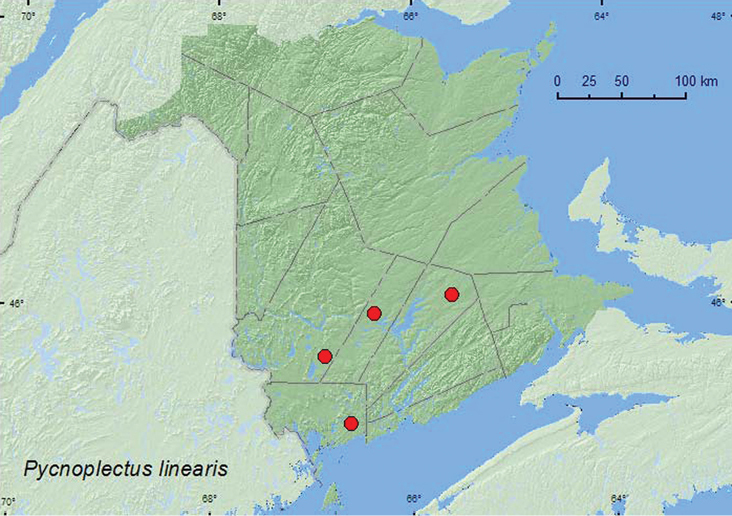
Collection localities in New Brunswick, Canada of Pycnoplectus linearis.